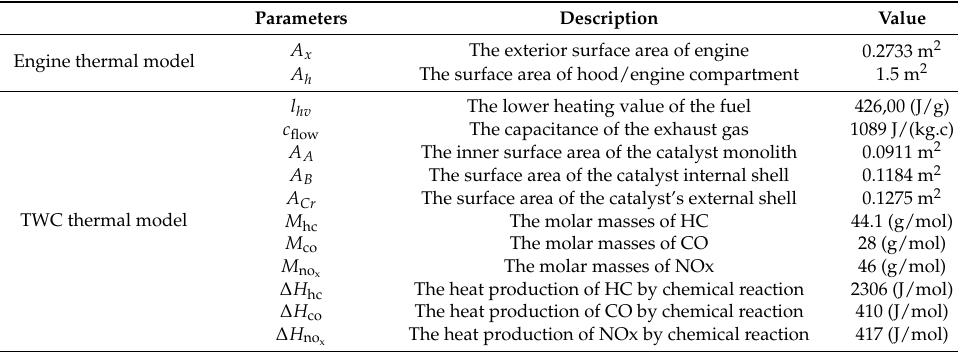
Table 3. Thermal models’ parameters are from Advanced Vehicle Simulator (ADVISOR).